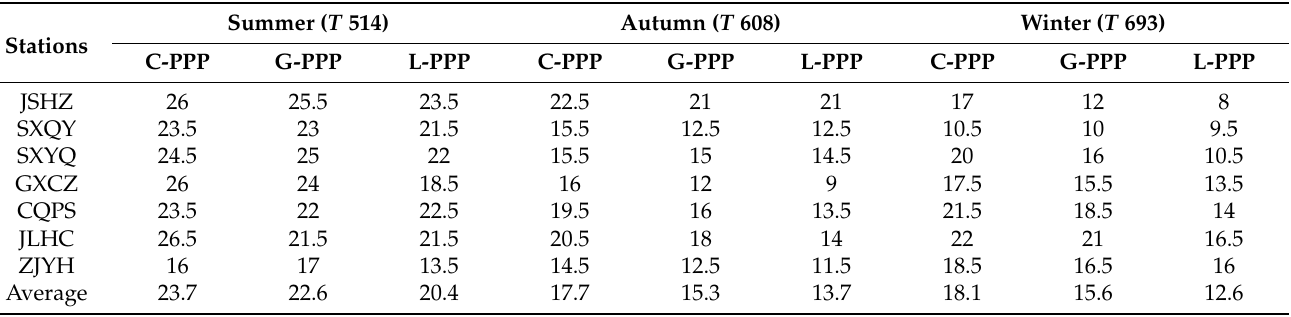
Table 5. PPP convergence time statistics of conventional ZTD corrected PPP (T-PPP) and LSTM-ZTD constrained PPP (L-PPP)